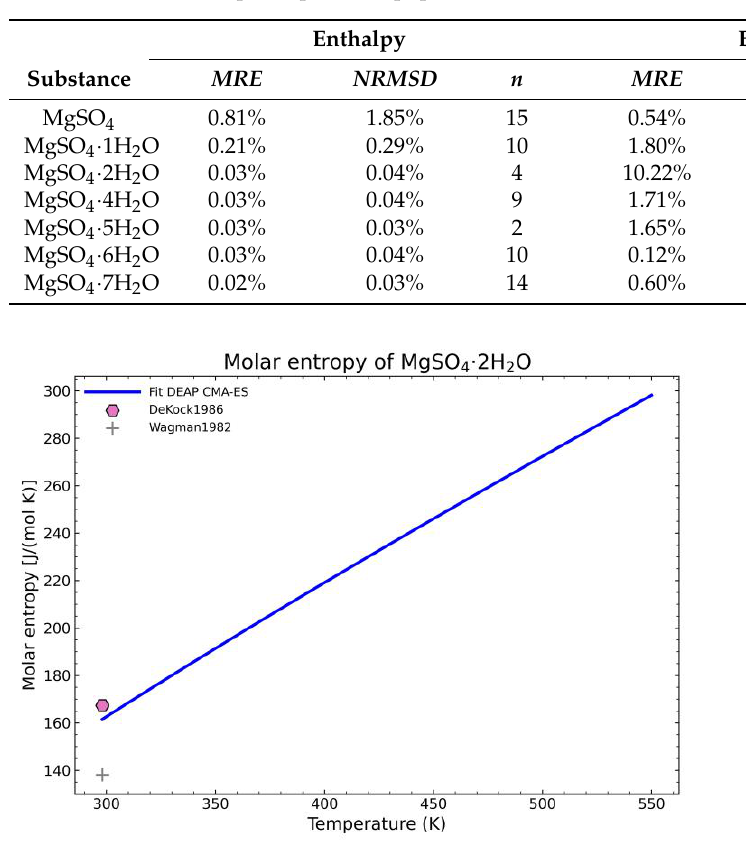
Figure 17. Fitted results of the entropy curve in the literature points region for MgSO 4 · 2H 2 O.